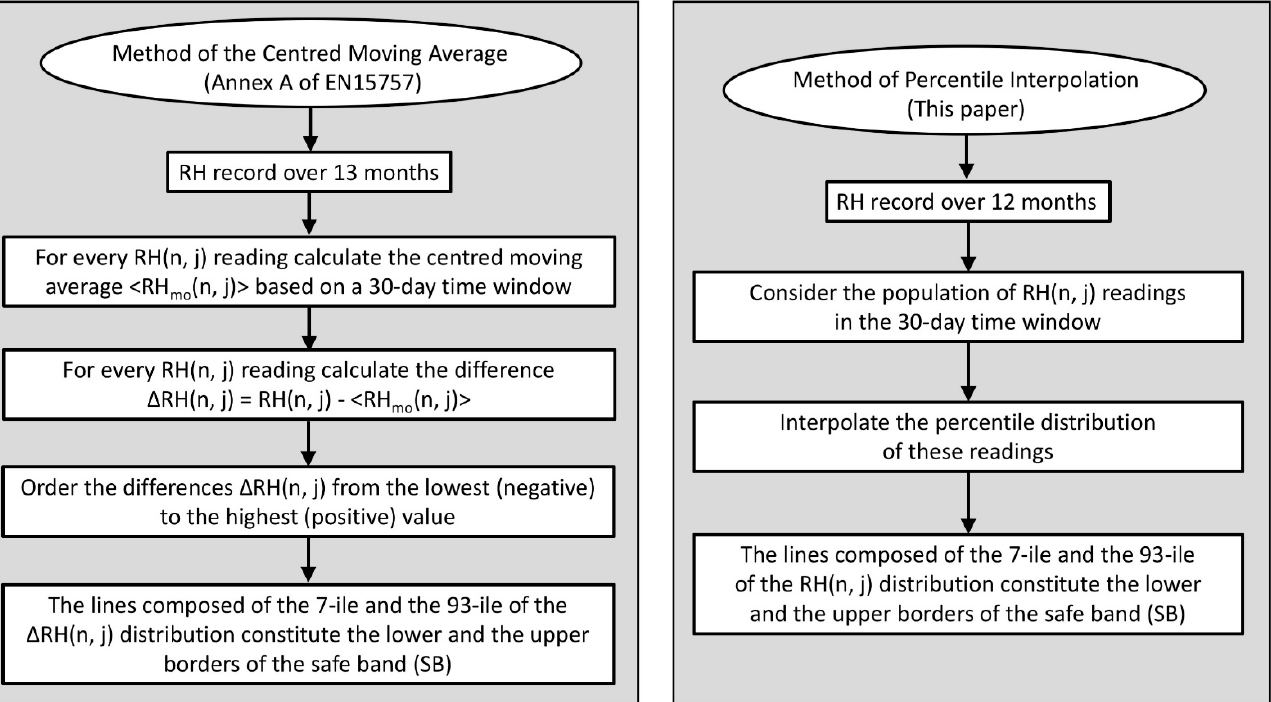
Figure 3. Flowcharts showing the method of the centred moving average used in the Annex A of EN15757, and the method based on the interpolation of percentiles to obtain the safe band (SB).